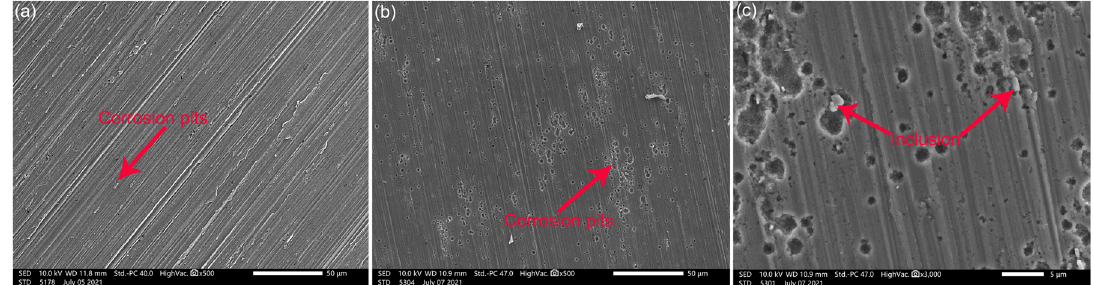
Fig. 3 SEM images of typical surface morphologies of specimens. a control, b and c 10 6 spores mL − 1 . Image c is part enlarge of image b .